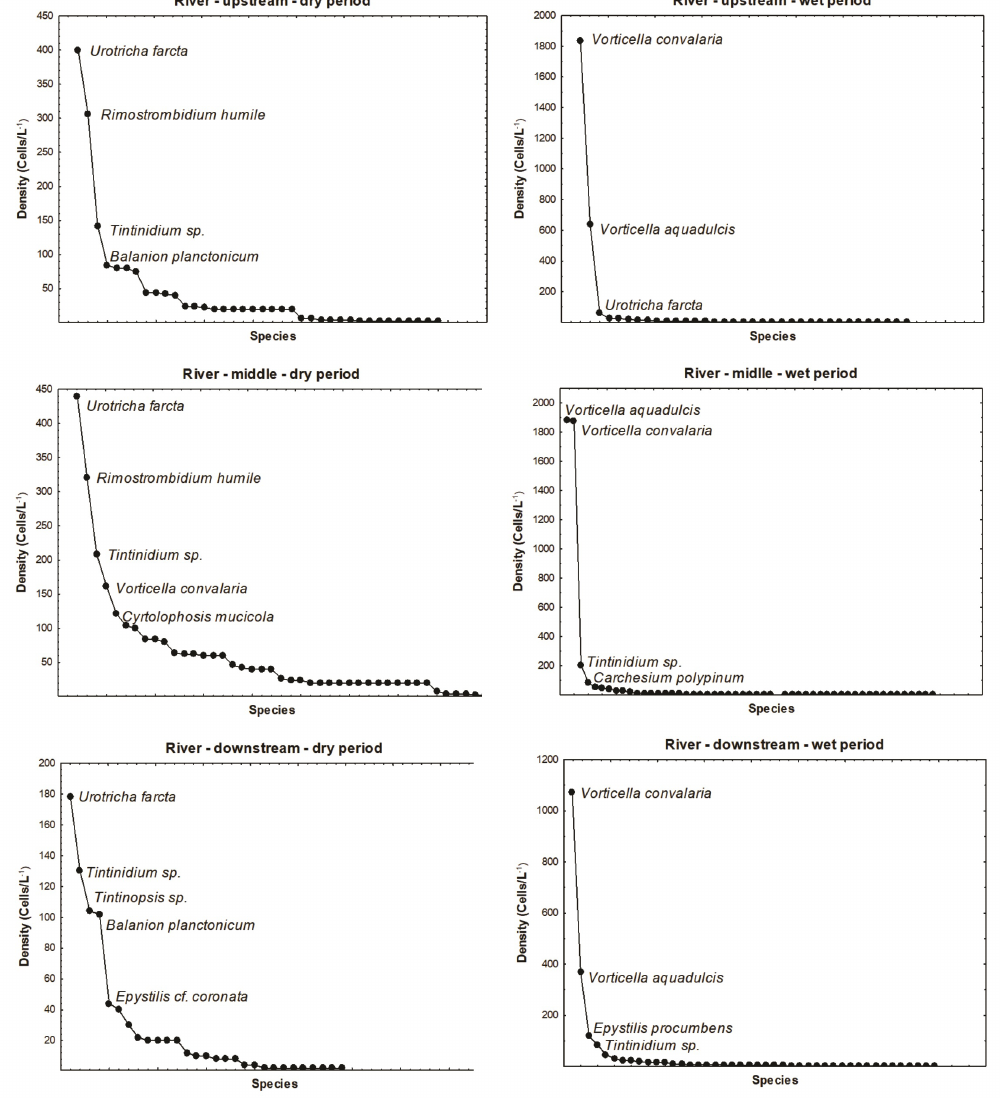
Figure 4. Plots of ciliates species abundance distribution in Paraná River main channel during the dry and wet